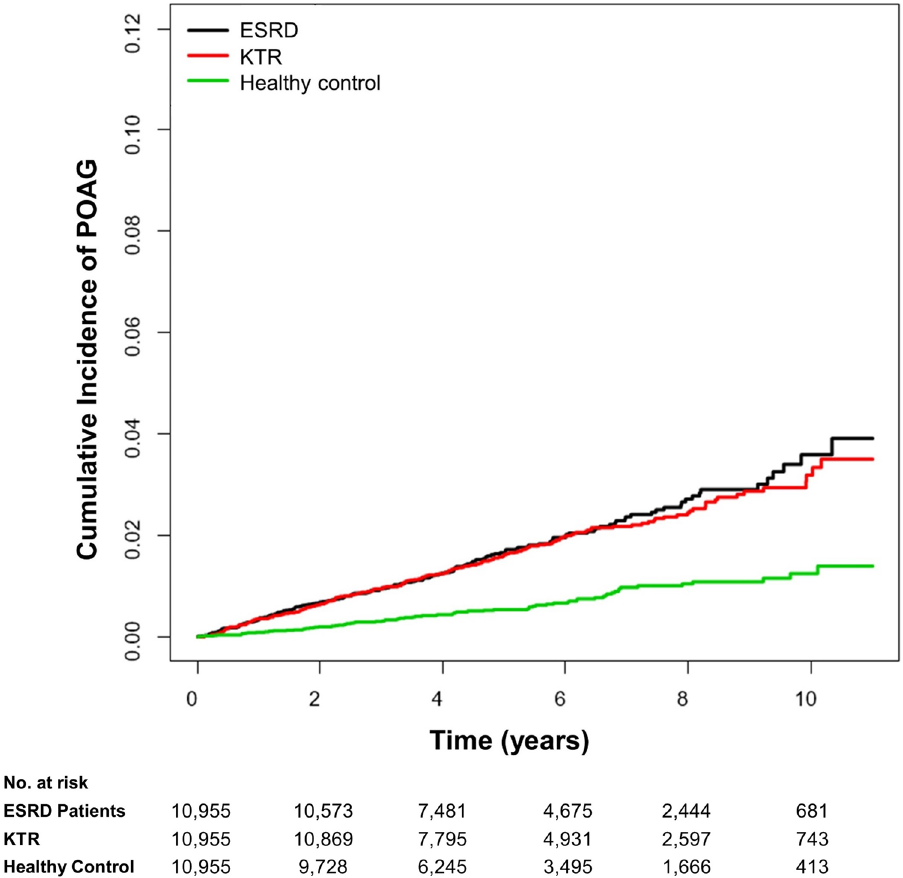
Figure 1. Cumulative Incidence of POAG in ESRD Patients, KTRs, and Healthy Controls. POAG incidence was significantly greater in ESRD patients (3.36/1,000 person-years, P < 0.001) and KTRs (3.22 /1,000 person- years, P < 0.001) as compared to healthy controls (1.20/1,000 person-years). However, there were no significant increase of risks for POAG incidence in neither ESRD patients ( P = 0.07) nor KTRs ( P = 0.08) when adjusted for age, sex, DM, HTN, dyslipidemia, income, and CCI. There was no significant difference in POAG incidence rates between ESRD patients and KTRs. KTR kidney transplant recipient, KT kidney transplant, CKD chronic kidney disease, ESRD end stage renal disease, POAG primary open-angle glaucoma, DM diabetes mellitus, HTN hypertension, CCI Charlson comorbidity index.